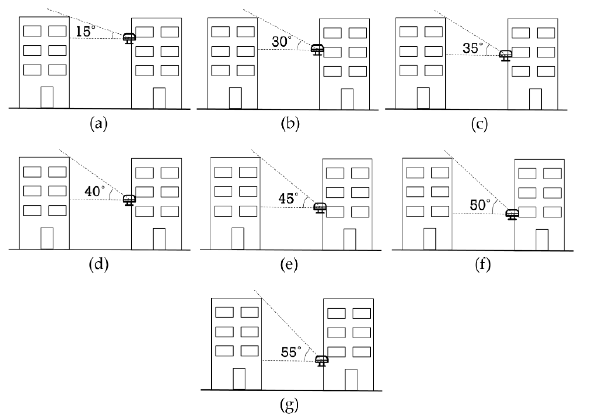
Figure 2. Illustration of NCCU station.